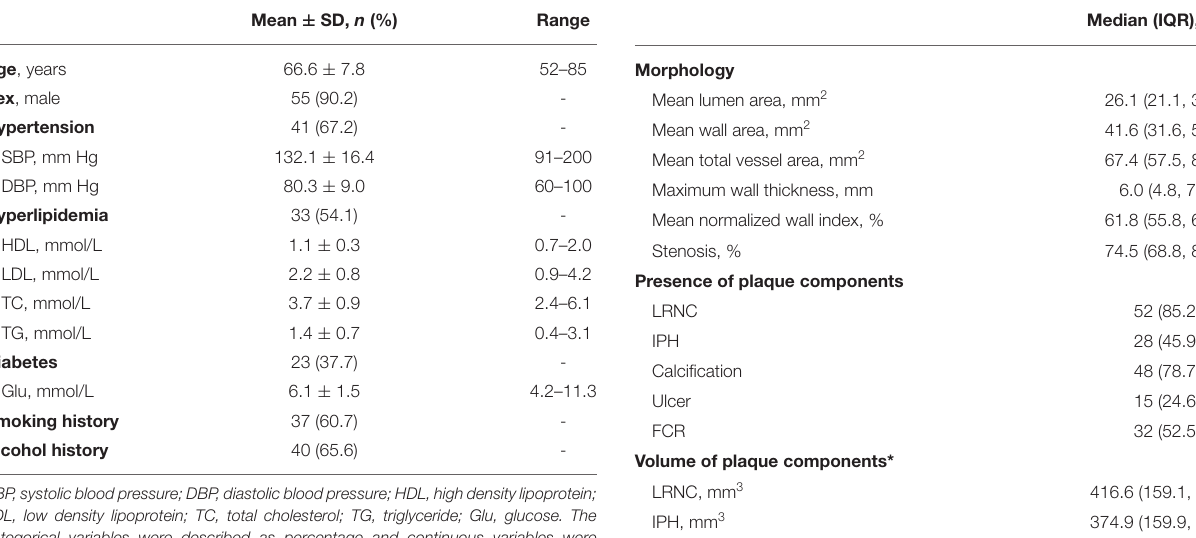
TABLE 1 | Clinical characteristic of study population ( n = 61). TABLE 2 | Carotid plaque characteristics of study population ( n =